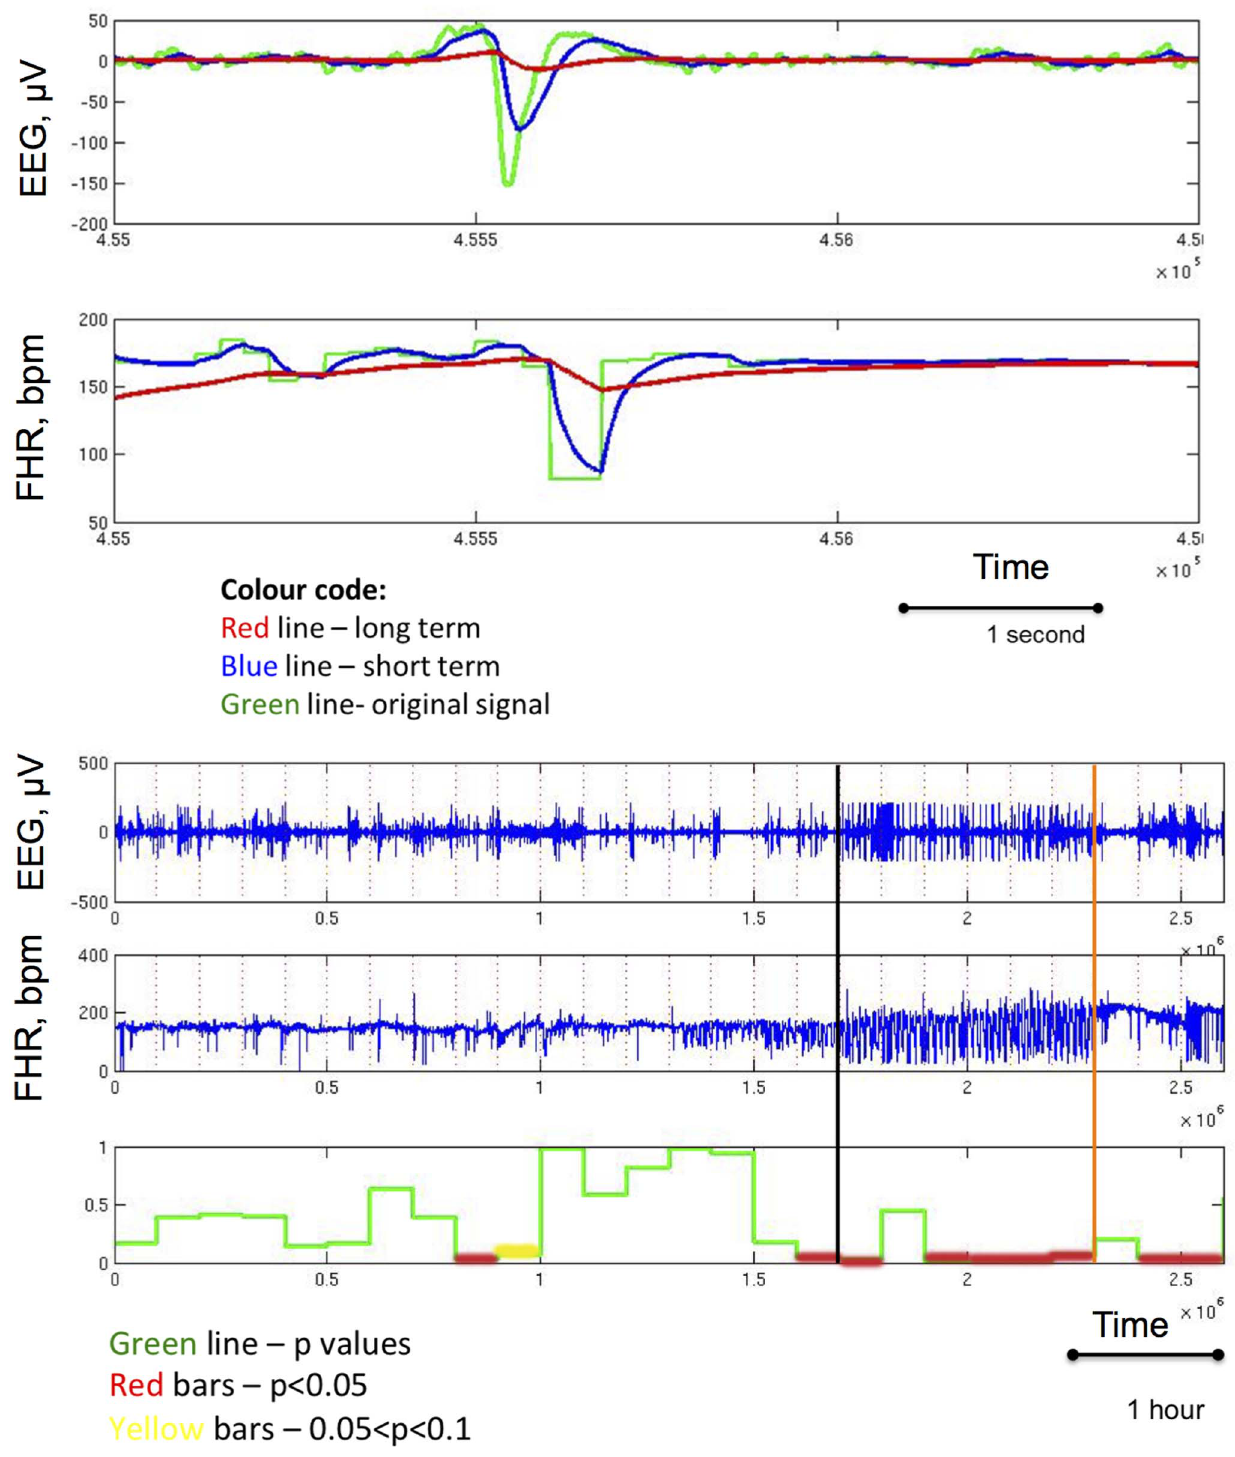
Figure 4. A representative example of crossing point detection. TOP: Single change point and crossing point detection. BOTTOM: Complete experimental recording demonstrating detection of EEG-FHR synchronisation based on the crossing point detection and subsequent validation using logistic regression analysis. Vertical black line denotes onset of EEG-FHR synchronization as per visual expert analysis. Vertical orange bar denotes the drop of pH to less than 7.00. The p-values over time are rendered by red lines where the null hypothesis (no EEG-FHR synchronization) was rejected, i.e. , p less than 5% and yellow lines where p value was between 5% and 10%. Note, that three subsequent crossing point detections are required to consider identifying EEG-FHR synchronization. This corresponds to a window length of 10 min (cf. Fig. 1).